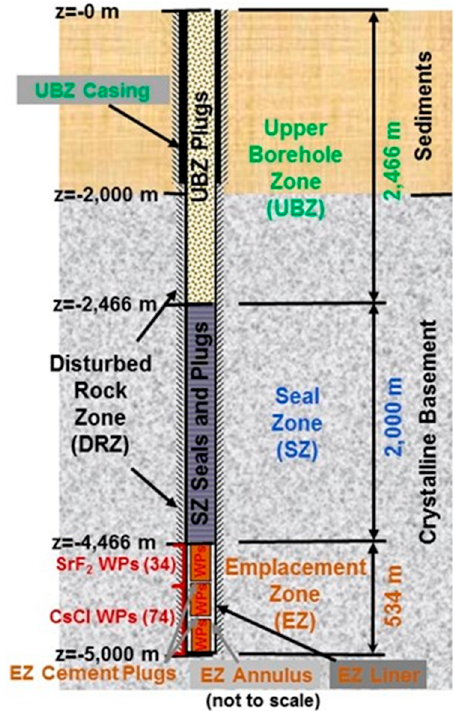
Figure 2. Schematic of the DBD concept for Cs/Sr capsules. Source: Freeze et al. [5].